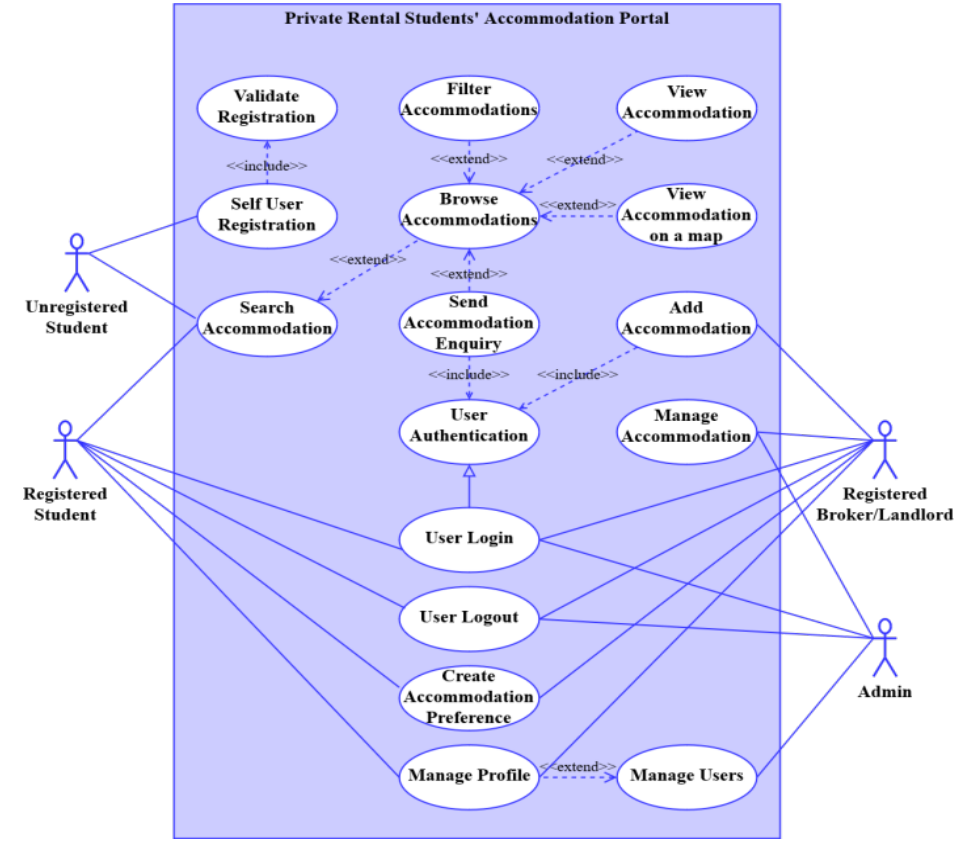
Figure 10. Use Case Digram for The Proposed